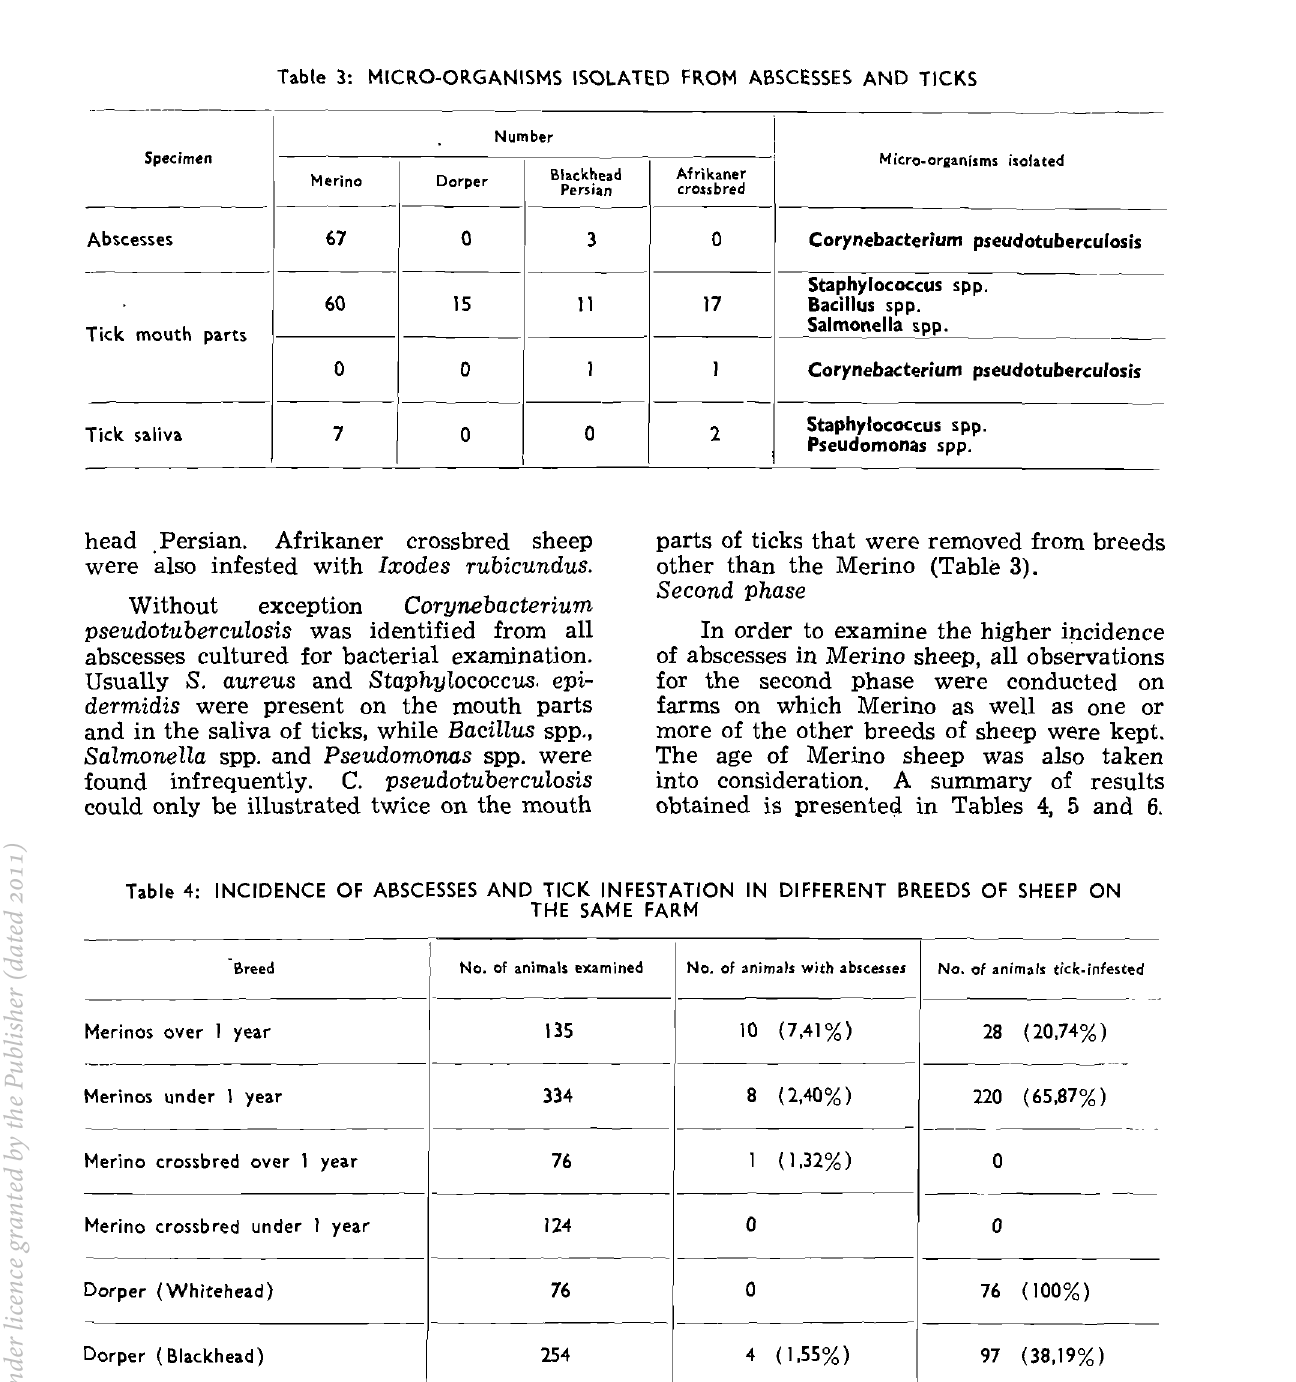
Table 3: MICRO-ORGANISMS ISOLATED FROM ABSCESSES AND TICKS